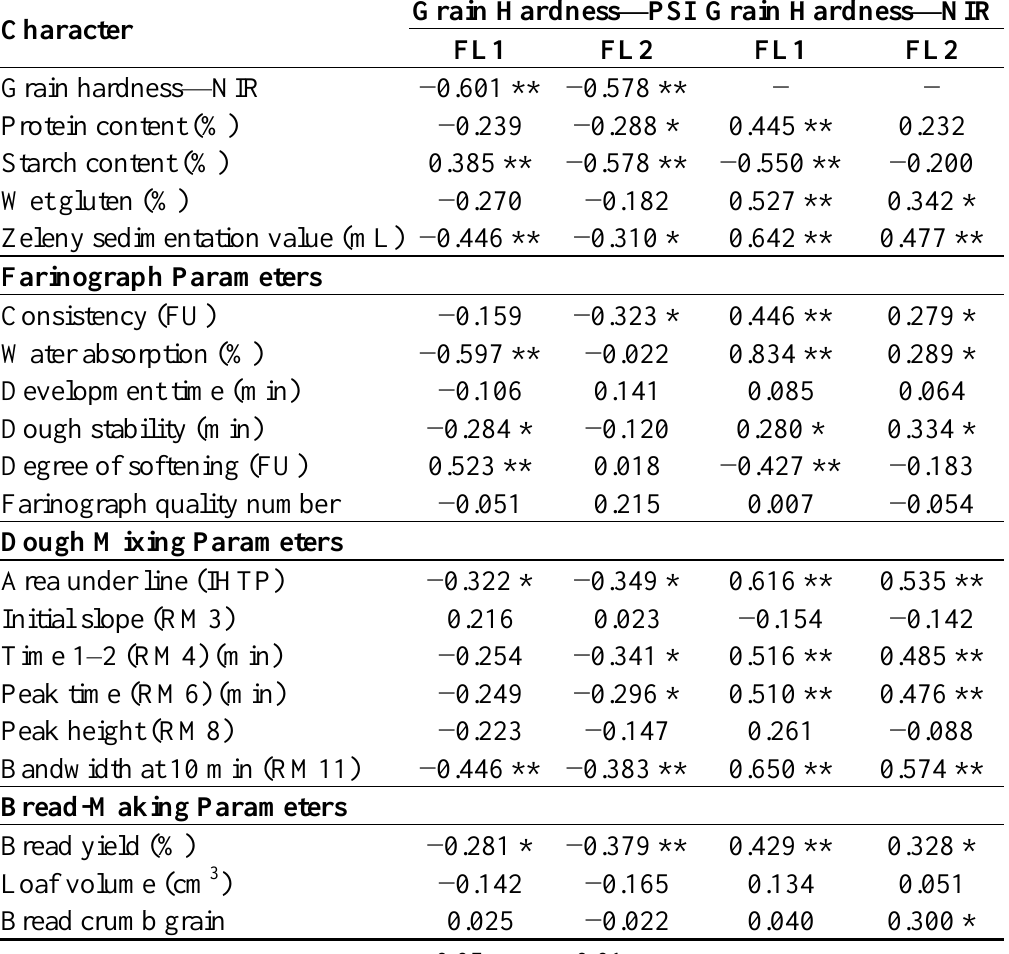
Table 5. Correlation coefficients between grain hardness measured by PSI and NIR technique (NIR) and quality characters of wheat lines assessed at two fertilization levels (FL1,